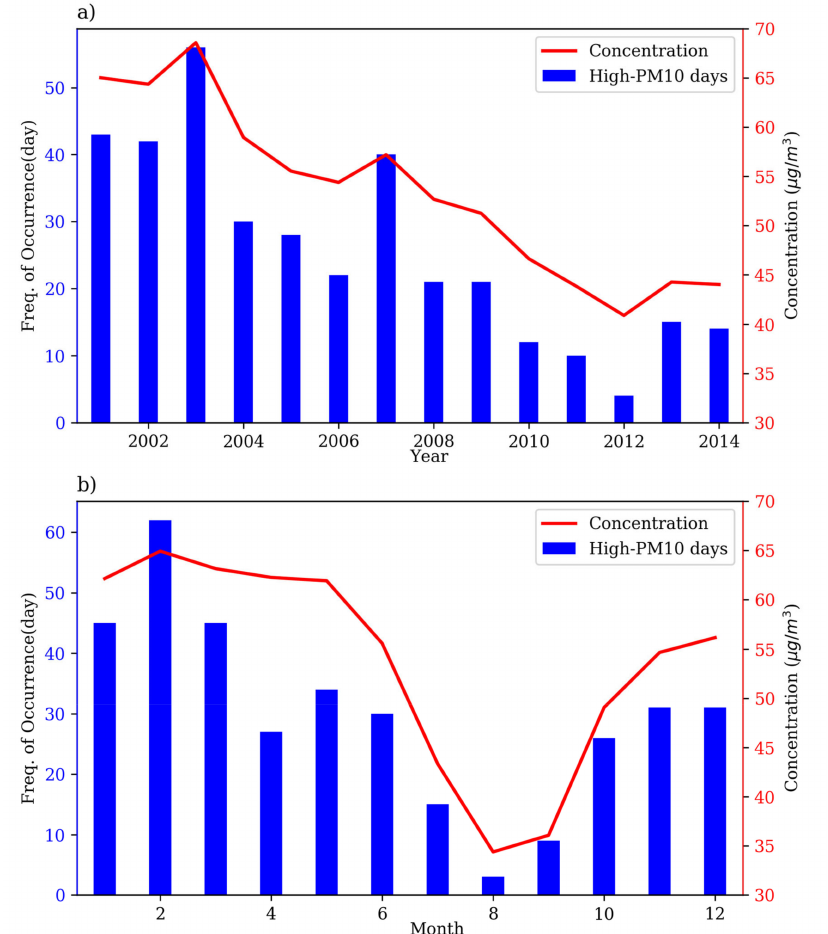
Figure 1. PM 10 variations in Seoul during the 2001–2014 period. Annual high-concentration days and mean concentration ( µ g / m 3 ) ( a ); monthly high-concentration days and mean concentration ( µ g / m 3 ) ( b ). High PM 10 days are defined as PM 10 > 100 µ g / m 3 over 24 h. Yellow dust cases were